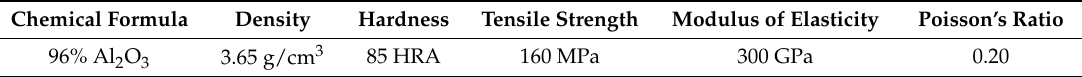
Table 3. Material properties of the ceramic